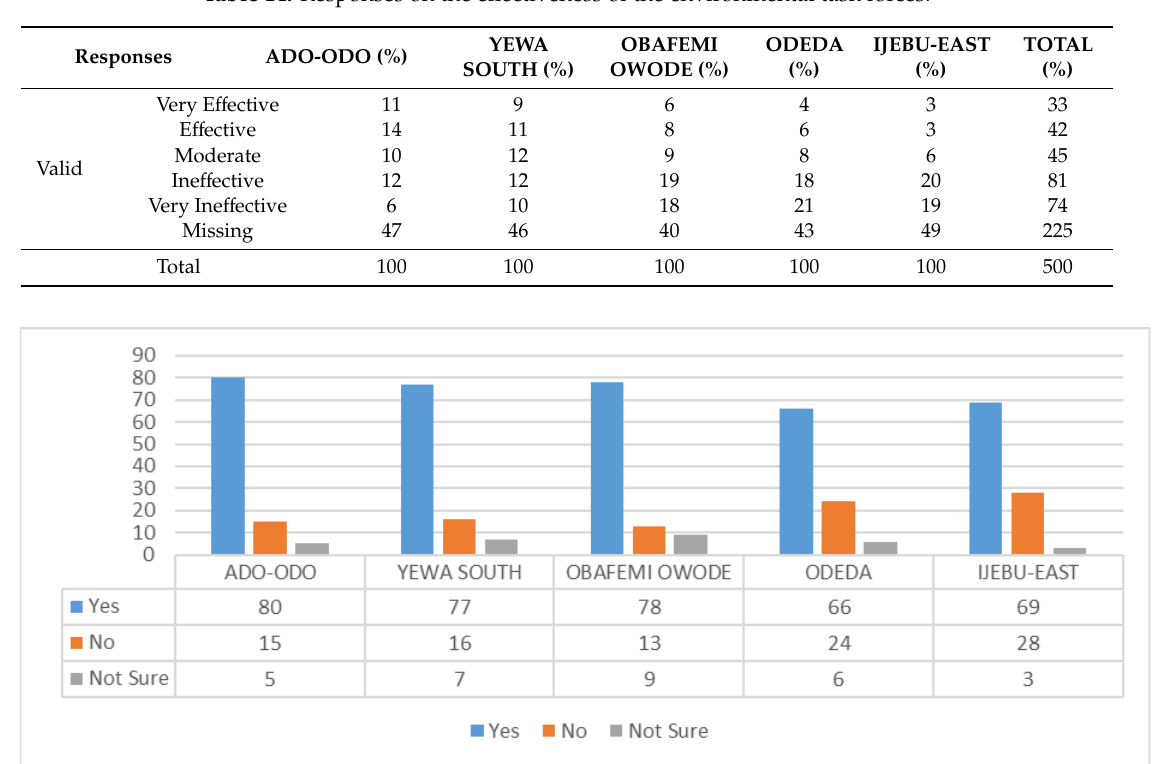
Figure 8. Should littering attract penalties?